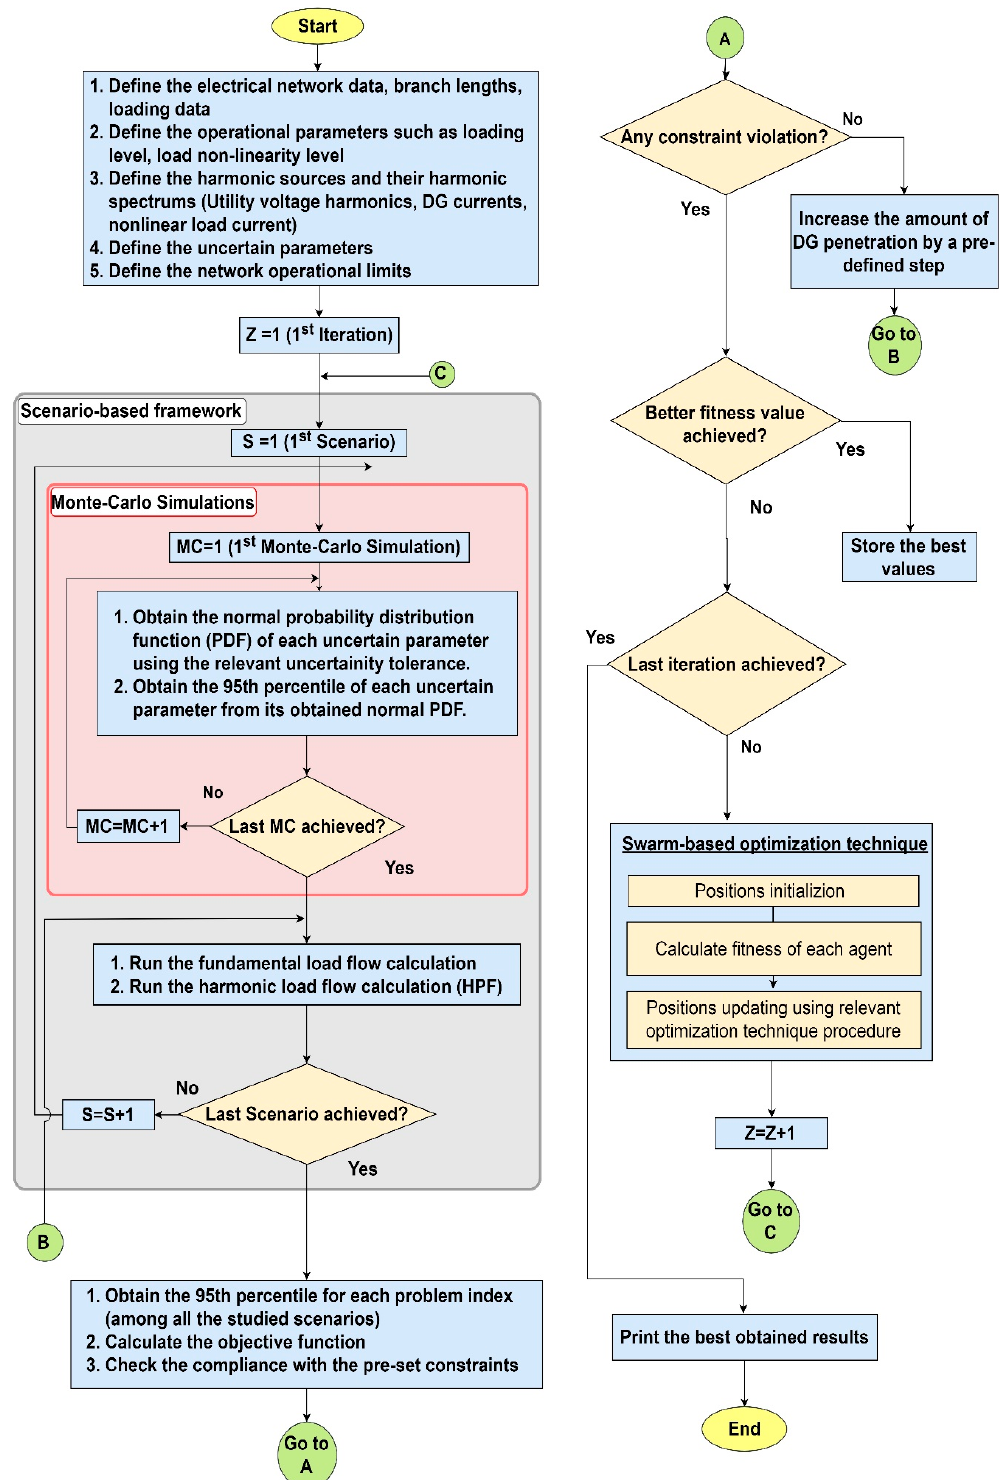
Figure 4. A comprehensive flowchart for the proposed problem formulation.